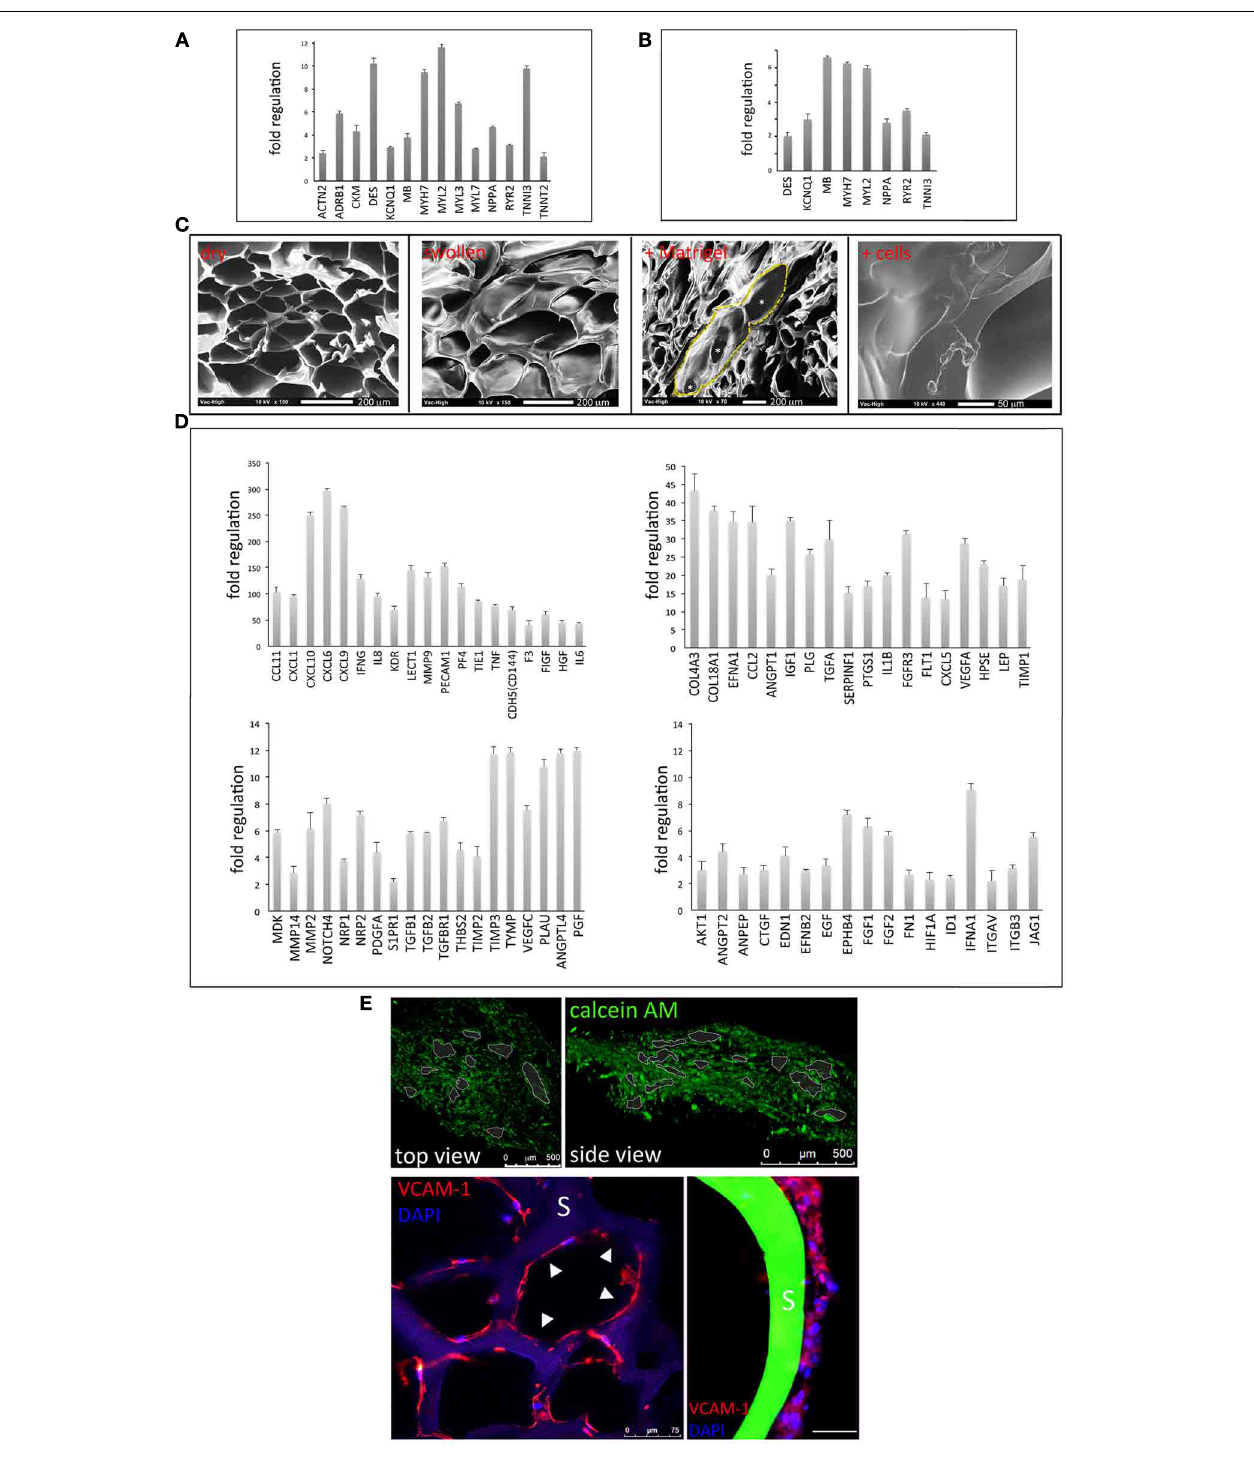
FIGURE 4 | Three-dimensional (3D) gelatin scaffolds support multilineage stem cell commitment. After 2 weeks of cardiac pre-commitment on TCPS, human cardiac progenitors (hCMPCs), seeded on 3D gelatin scaffolds and stimulated with cardiogenic differentiation medium (CDM) for further 1 week, up-regulate some cardiac-specific genes, as